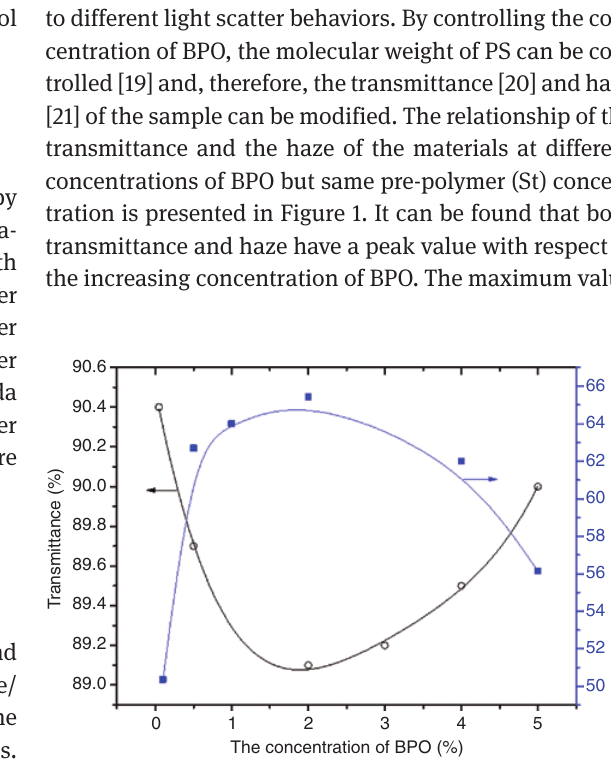
Figure 1: The relation between the concentration of BPO and the optical performance of the sample (The concentration the pre- polymer is